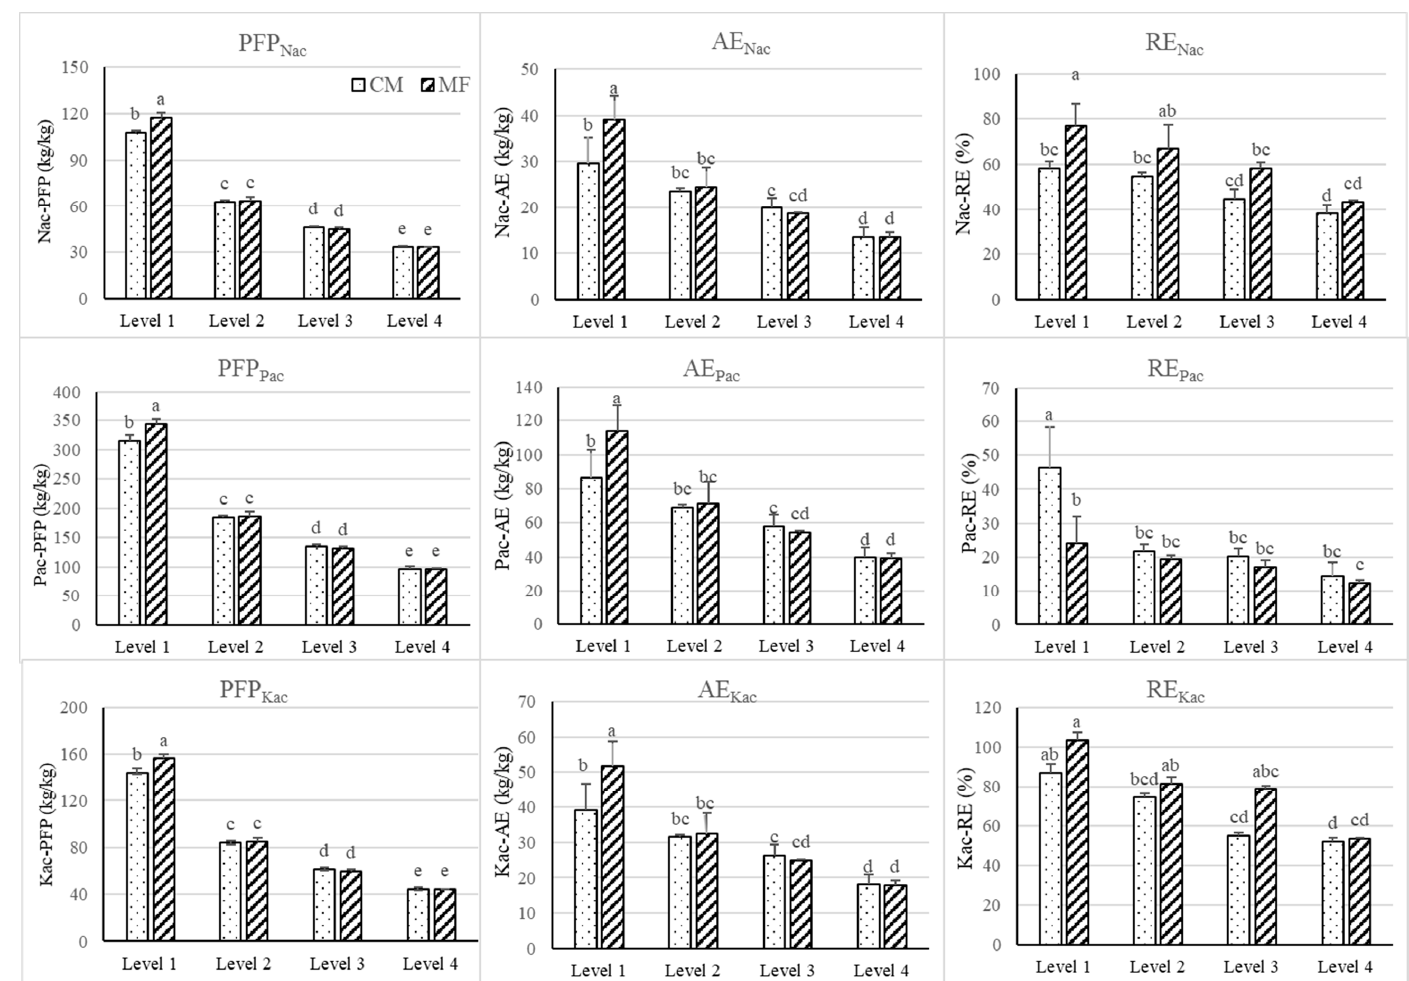
Figure 3. Accumulated N, P and K use efficiency including partial factor productivity (PFPac), agronomic efficiency (AEac) and recovery efficiency (REac) in response to different fertilization treatments in North China Plain region, China. CK: Control treatment (non-fertilized); CM: cattle manure; MF: mineral fertilizer; Level